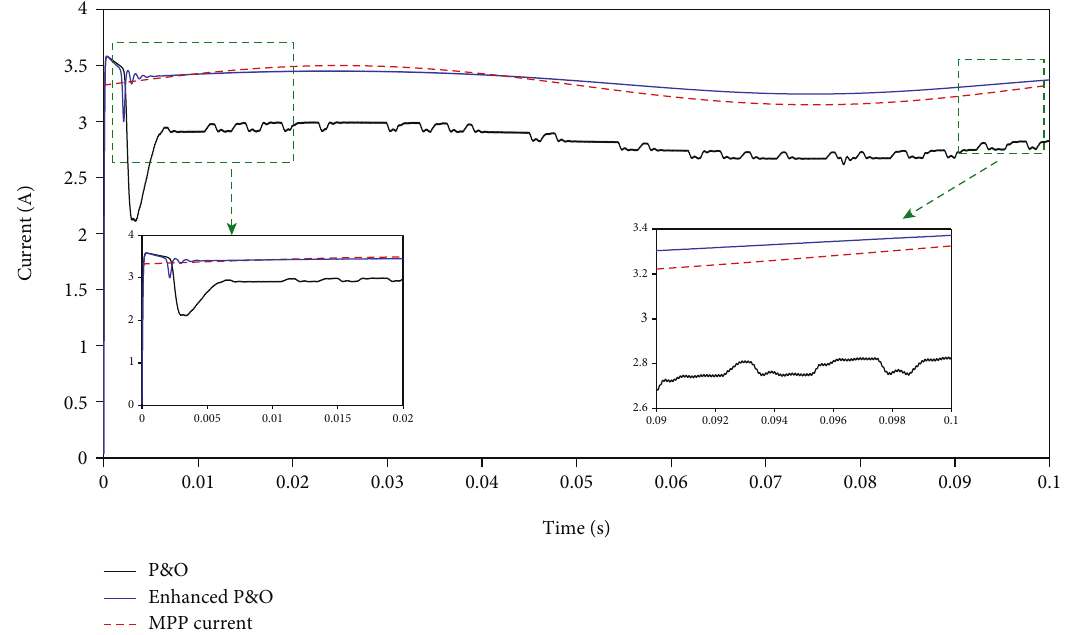
Figure 17: Tracking of MPP current with P&O and enhanced MPPT method under Test 2.